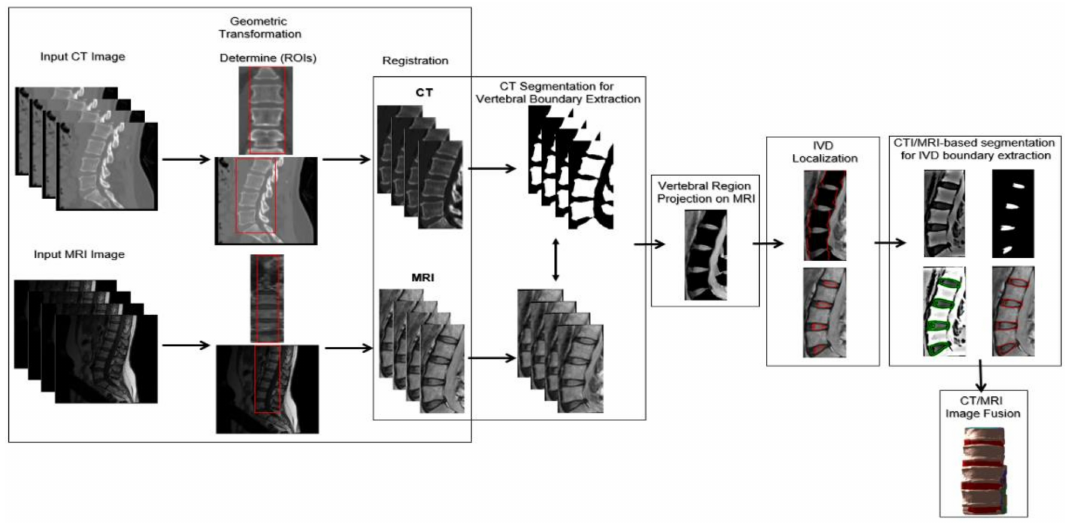
Figure 1. Summary of the main stages of the proposed